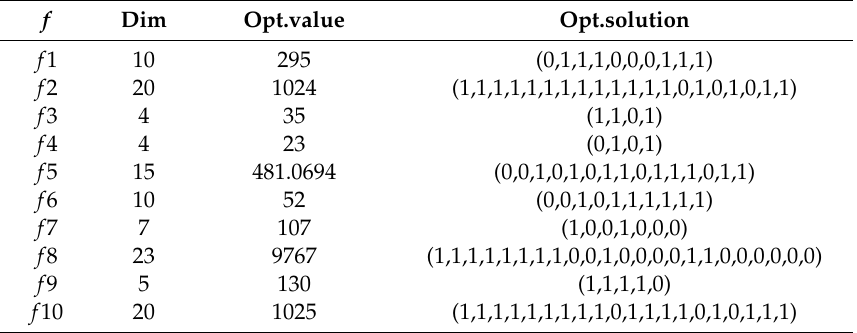
Table 4. The basic information of 10 standard low-dimensional 0-1KP instances.